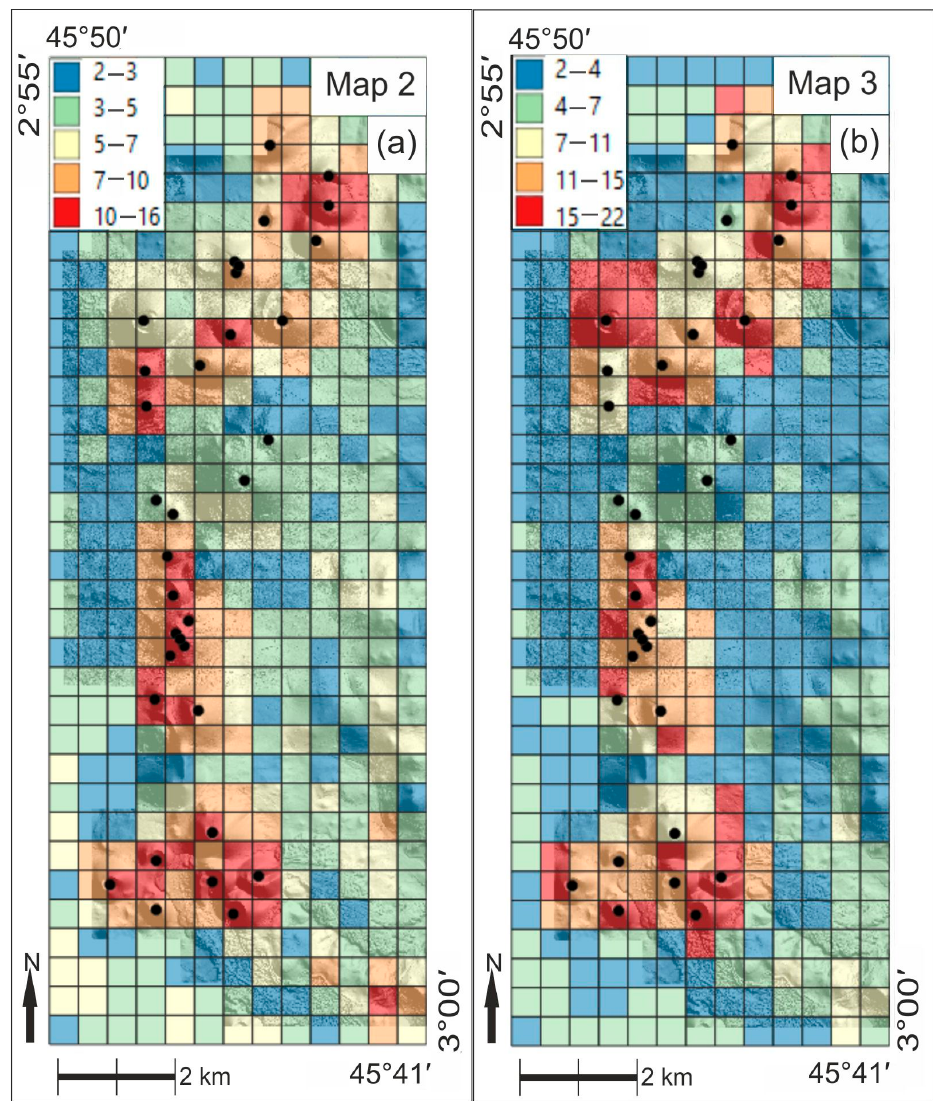
Figure 9. Geodiversity maps of the examined area. ( a ) Geomorphology subindex values were calculated with the addition of two variables: cone presence in a certain cell (score 0 or 1) and the number of different sectors in a certain cell (Map 2). ( b ) Geomorphology subindex values were calculated with the help of two variables: cone presence in a certain cell (score 0 or 1) and the median of sector values in a certain cell (Map 3). Black dots indicate the scoria cone centers. We also examined what map we would get in the case of adding the abovementioned new subindices to the original methodology supplemented with geomorphons. The chain of cones also appears here, and the areas outside have become much more diverse owing to the geomorphons (Figure 10).